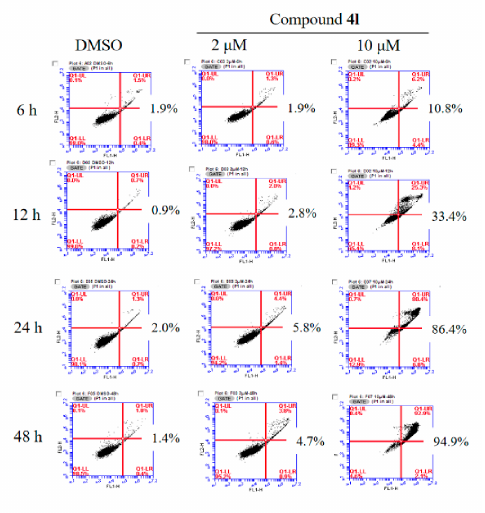
Figure 2. Apoptosis observation changes in compound 4l treated K562 cells by different concentration (0, 2, 10 µ M) and by different period of time (6, 12, 24, 48 h).